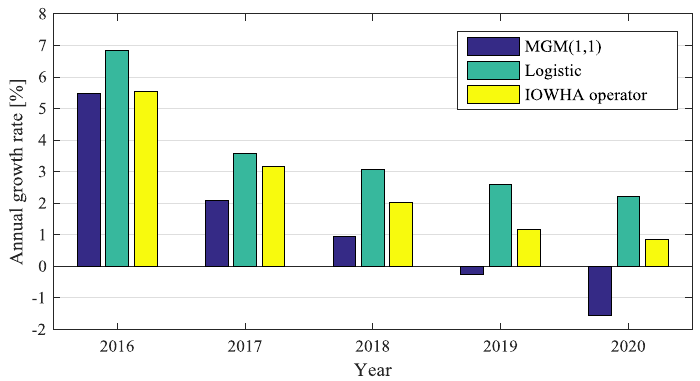
Figure 7. Annual growth rate analysis of China’s electricity demand for e casting in 2016–2020.